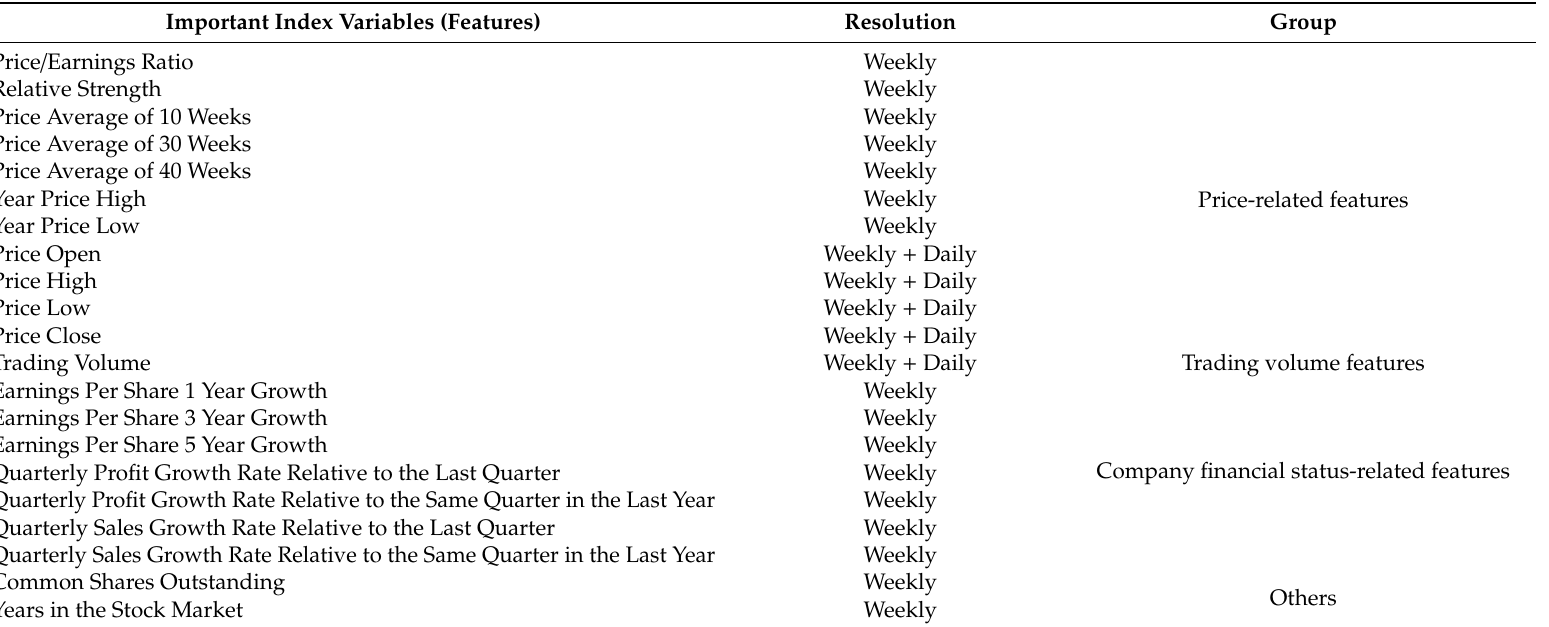
Table 1. Important index variables for stock performance